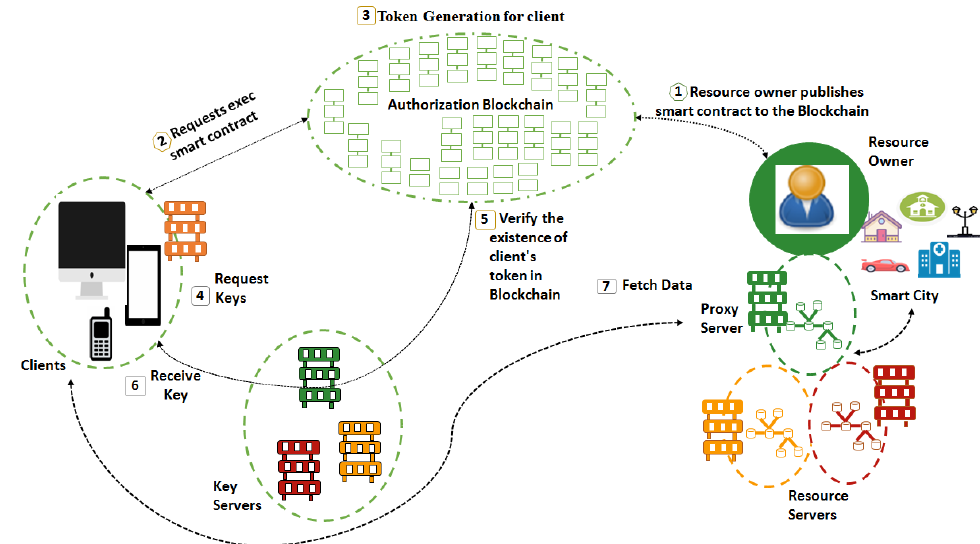
Figure 7. Block diagram of the proposed